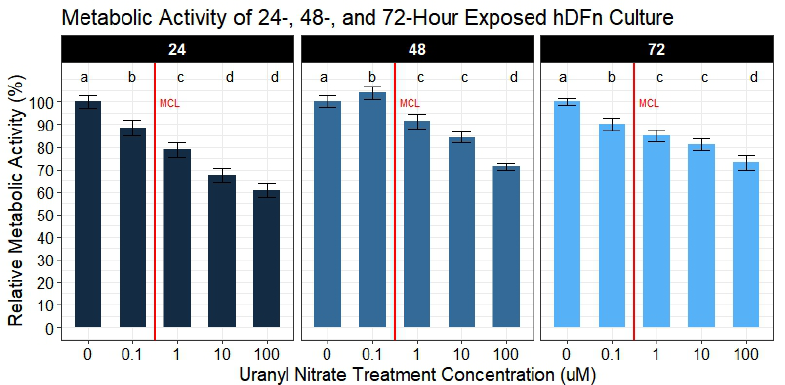
Figure 1. Metabolic activity results of UN exposured hDFn. UN decreases PrestoBlue textTM readings in cultured human dermal cells at levels below and above the EPA MCL. Bar charts are faceted by exposure time representing the mean metabolic activity percentage ± StdErr of each treatment group (n = 6 done in sextuplicate). All UN concentrations are in µ M with -0- representing control group. Statistically significant differences between groups are illustrated by compact letter display with different letters at the top representing a balanced Tukey pairwise t -tests where p -value ≤ 0.05. Group means followed by a common letter were not different at 5% level of significance. Vertical red line illustrates the EPA MCL threshold for uranium (0.126 µ